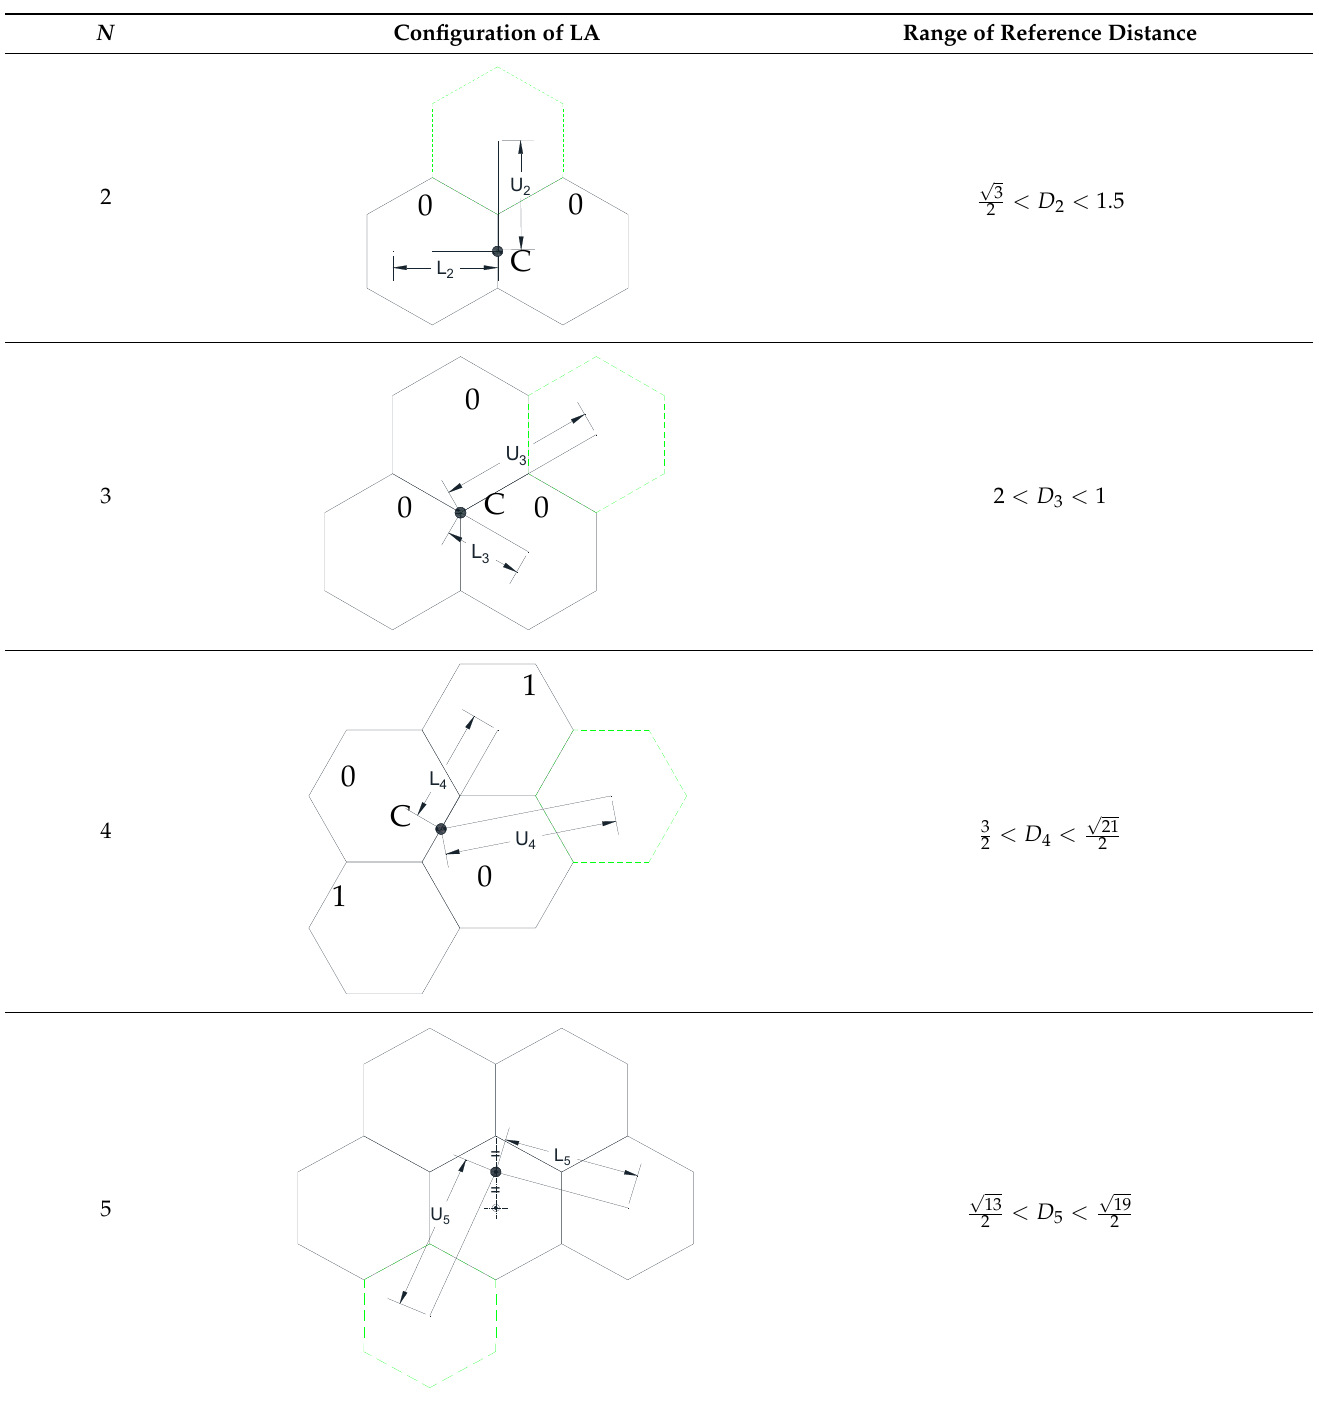
Table 1. Configuration of the LA and range of the reference distance for various N.